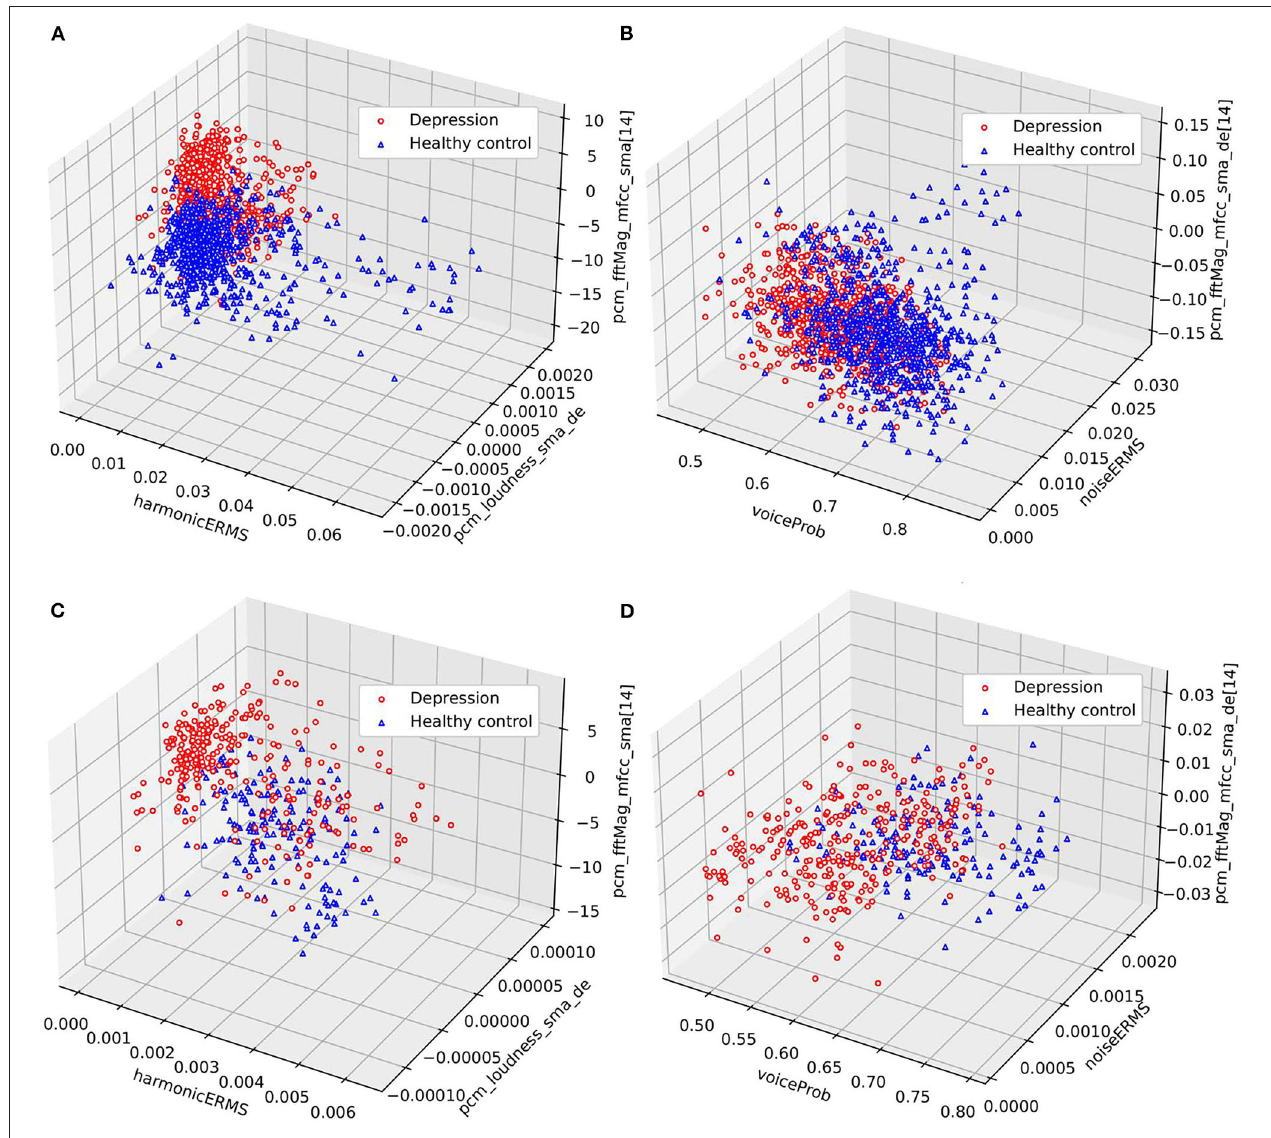
FIGURE 3 | Cluster comparisons. (A,B) are clustering results on the DAIC-WOZ corpus, while (C,D) are clustering results on the MODMA